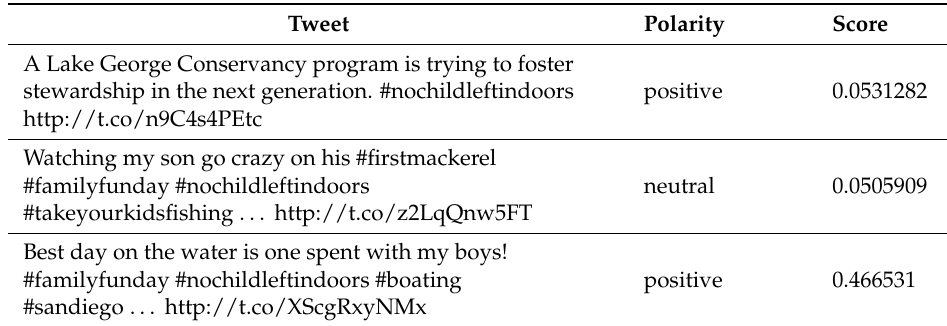
Table 8. Tweets comprised by the hashtag #nochildleftindoors.